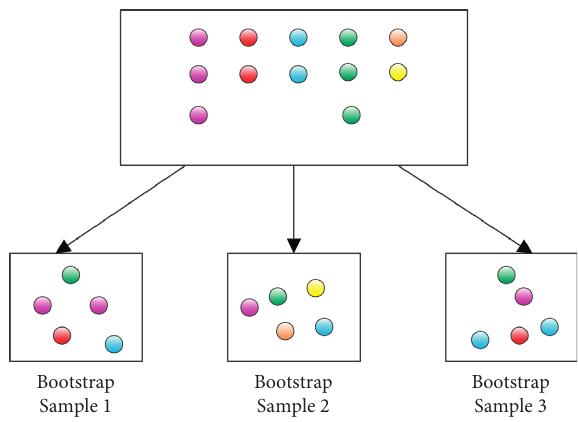
Figure 5: Resampling method based on bootstrap.